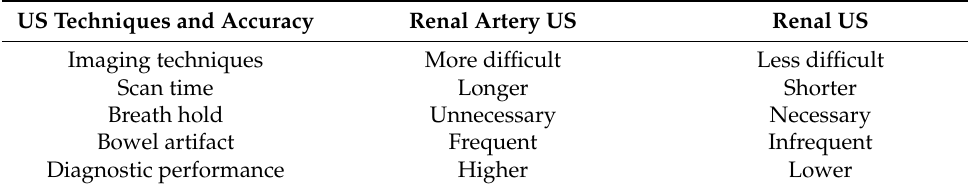
Table 2. Renal artery US versus renal US in detecting for RAS.